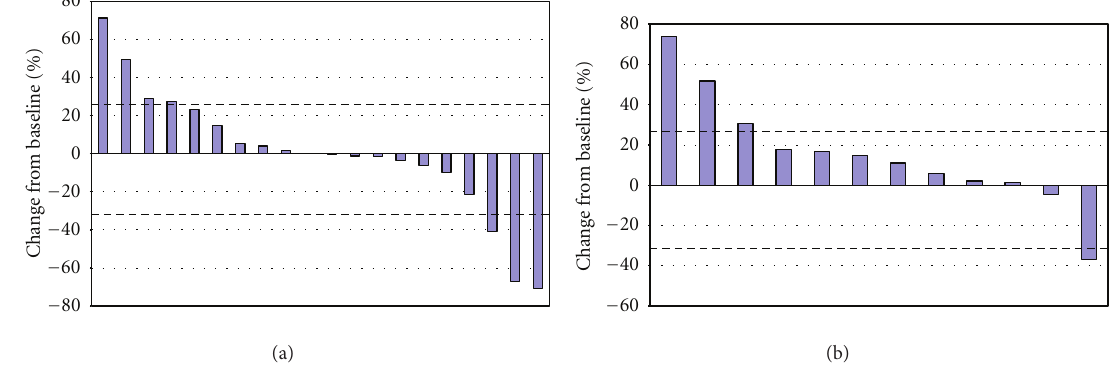
F 2: Waterfall plots of FDG uptake in the tumors aer treatment with . Every bar represents an individual patient. Dashed lines at 30 from baseline of SUV 18 mean metabolic disease and progressive metabolic disease or partial metabolic response, respectively. T 2: Radiation-absorbed doses to organs from 188 Re-6D2 (mSv/MBq). Cohort Liver Spleen Kidneys Bone marrow Urine bladder wall Whole body Phase 1a